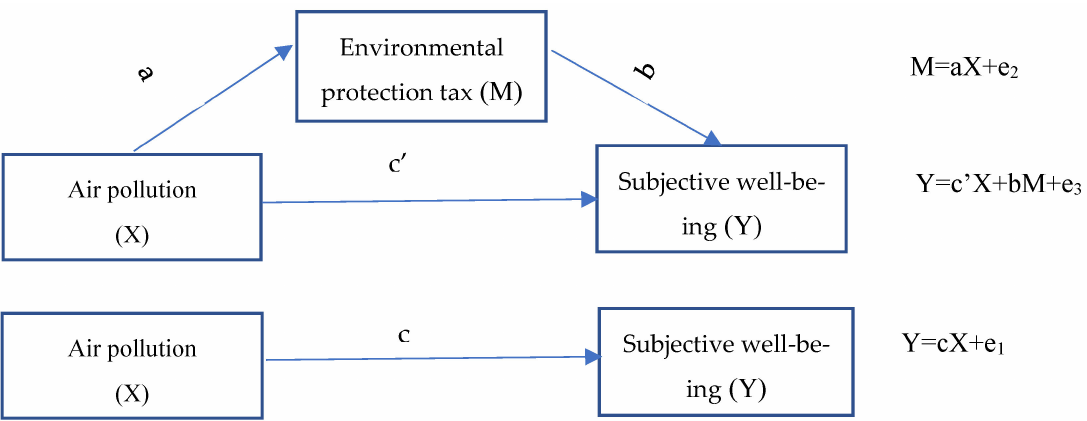
Figure 1. The relationship between subjective air pollution, the environmental protection tax, and well-being. Note: a: The regression coefficient between subjective air pollution and environmental protection tax; b: the regression coefficient between environmental protection tax and well-being; c: the total effects of subjective air pollution on well-being; and c’: the direct effects of subjective air pollution on